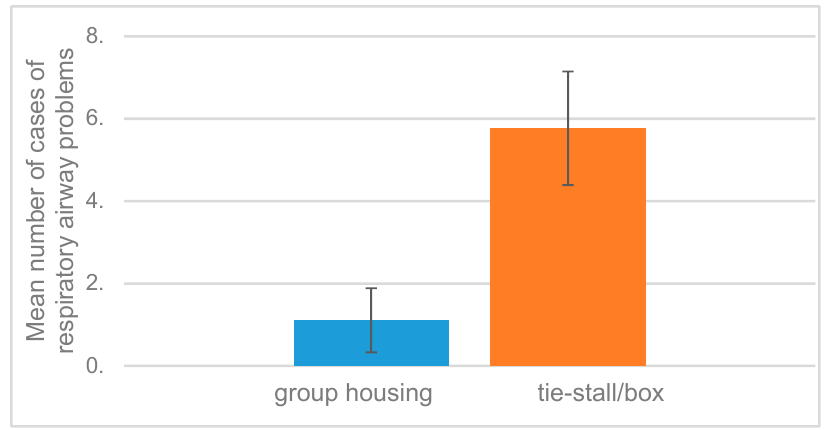
Figure 2. Mean number of horses with airway problems recorded by riding school managers during the previous six months.